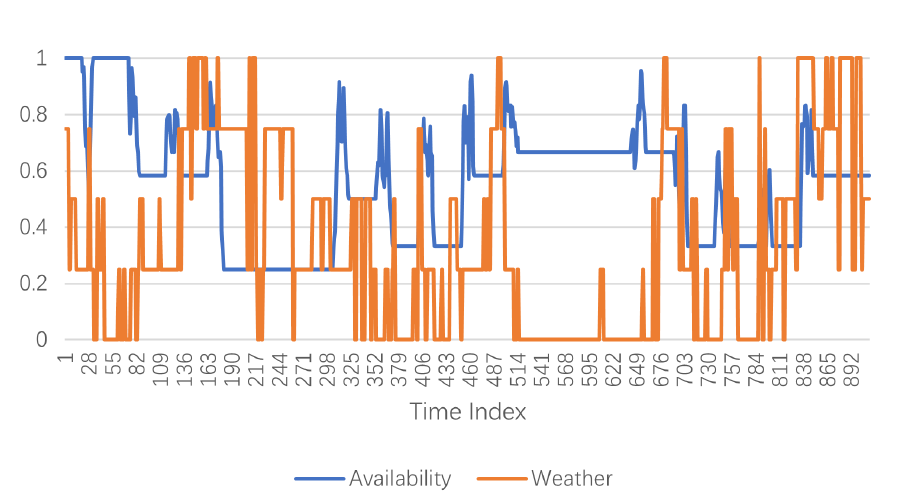
Figure 3. Weather and EV charging station